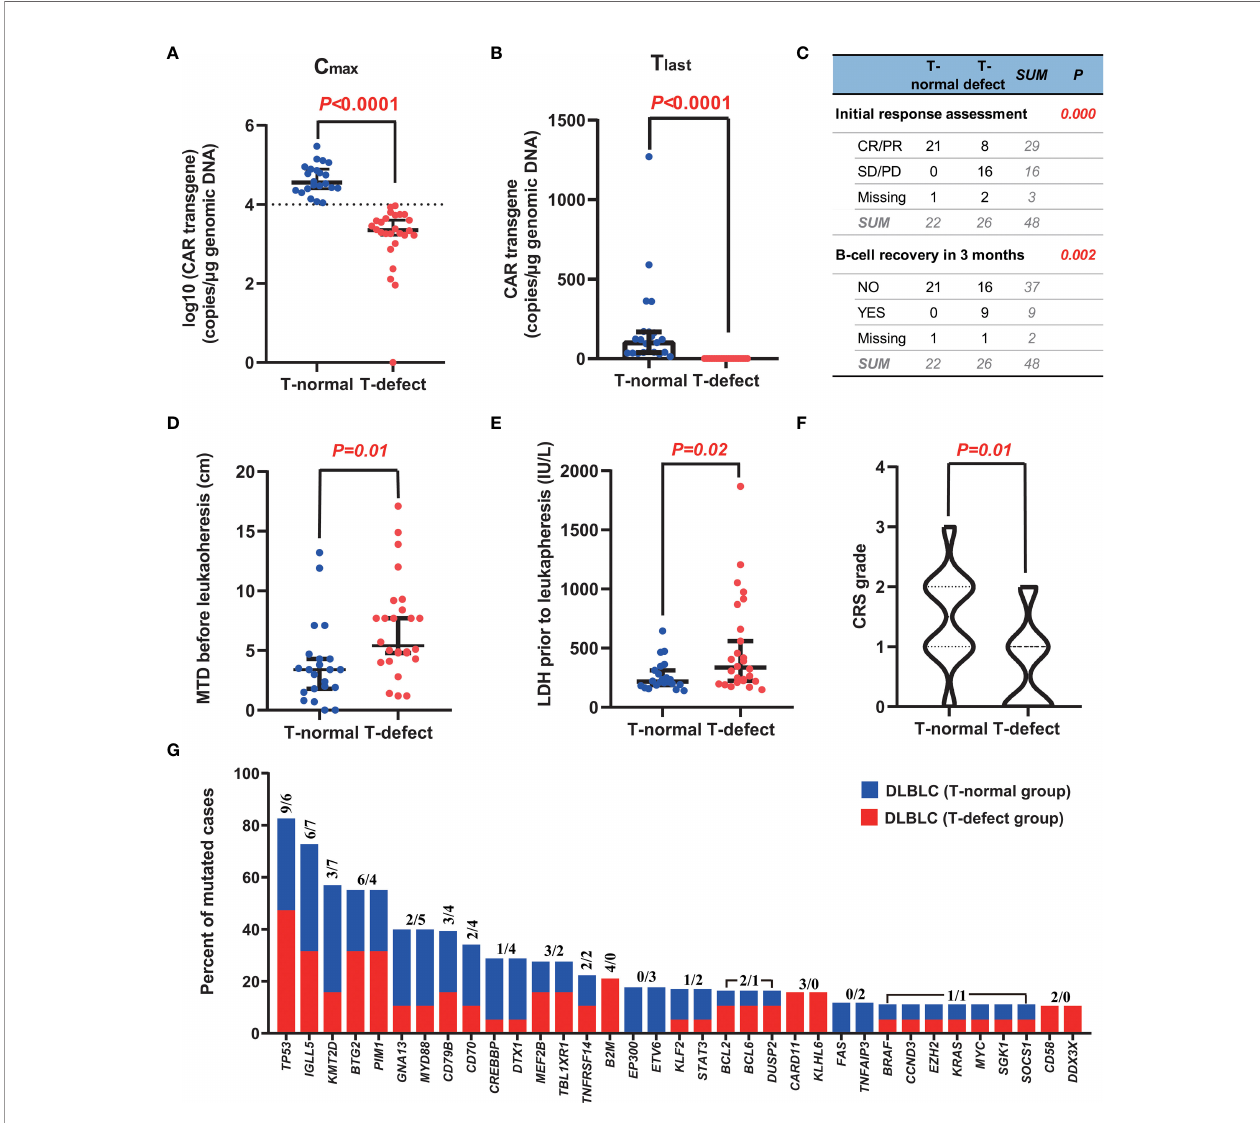
FIGURE 2 | Typical characteristics of the two groups. (A, B) CAR T-cell expansion (C max ) and persistence (T last at +3 months) in peripheral blood were greater in the T-normal group than in the T-defect group (p<0.0001). (C) The initial response to CAR-T cell therapy was also considerably better in patients with T-normal function than in those with T-defect function (p<0.0001). In addition, there were signi fi cant differences in B-cell recovery in the T-normal group compared with the T-defect group (p=0.002). (D, E) MTD and LDH level in the T-normal and T-defect groups before leukapheresis demonstrate signi fi cant differences (p=0.01, and 0.02, respectively) according to the Mann-Whitney Test. (F) The T-normal group showed higher CRS grades than the T-defect group according to a Pearson chi-square test (p=0.01). (G) Recurrent somatic mutations in DLBCL. Shown is the prevalence of the indicated genetic abnormalities in 57 genes in the T-normal group (in blue) and T-defect group (in red). The two numbers for each mutation represent the counts of individuals carrying the genetic alterations in the T-defect and T-normal groups, respectively. The somatic origin of the mutations was con fi rmed by analysis of paired PBMC germline DNA. CAR, chimeric antigen receptor; CR, complete remission; CRS, cytokine release syndrome; PD, disease progression; PR, partial remission; SD, stable disease; SNP, single nucleotide polymorphism; MTD, maximal tumor